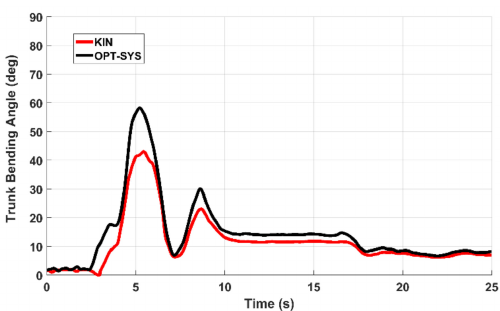
Figure 7. Example of the ANG TRUNK variations during the AC task performance: the secondary peak at 8.5 s indicates the presence of an instability event in the final standing stance.